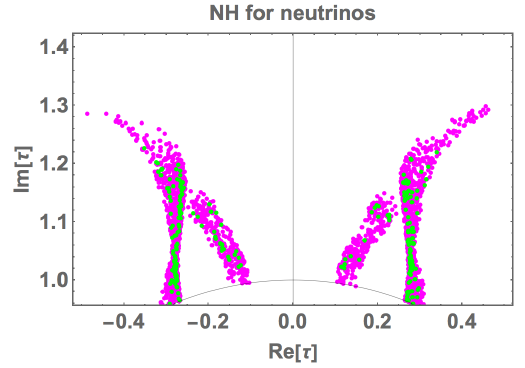
Figure 1 . Allowed regions of τ for NH, where green and magenta points correspond to p χ 2 ≤ 2 and 3 , respectively. The solid curve is the boundary of the fundamental domain, | τ | = 1 .